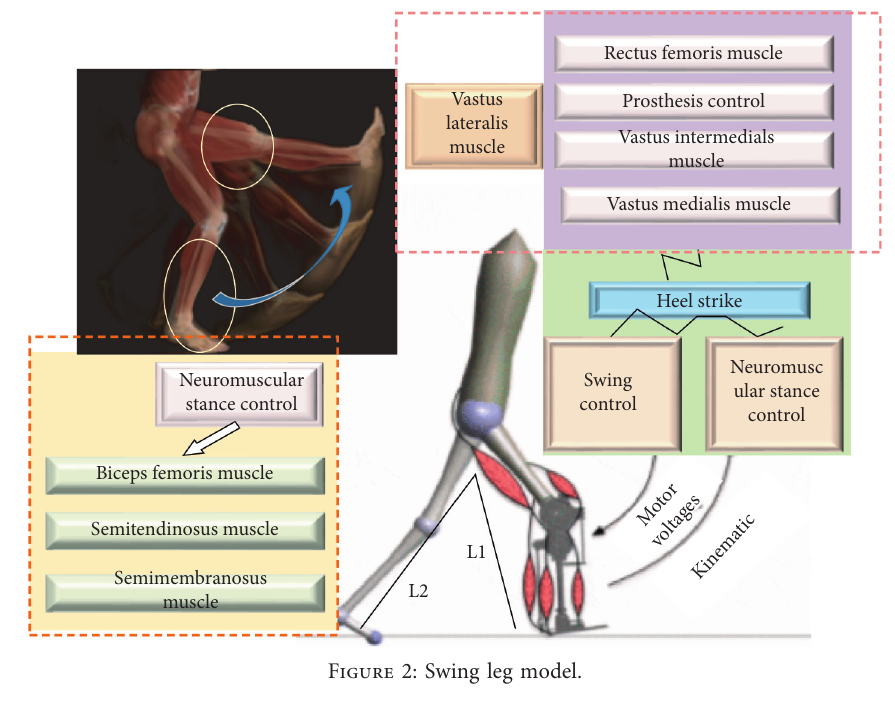
Figure 2: Swing leg